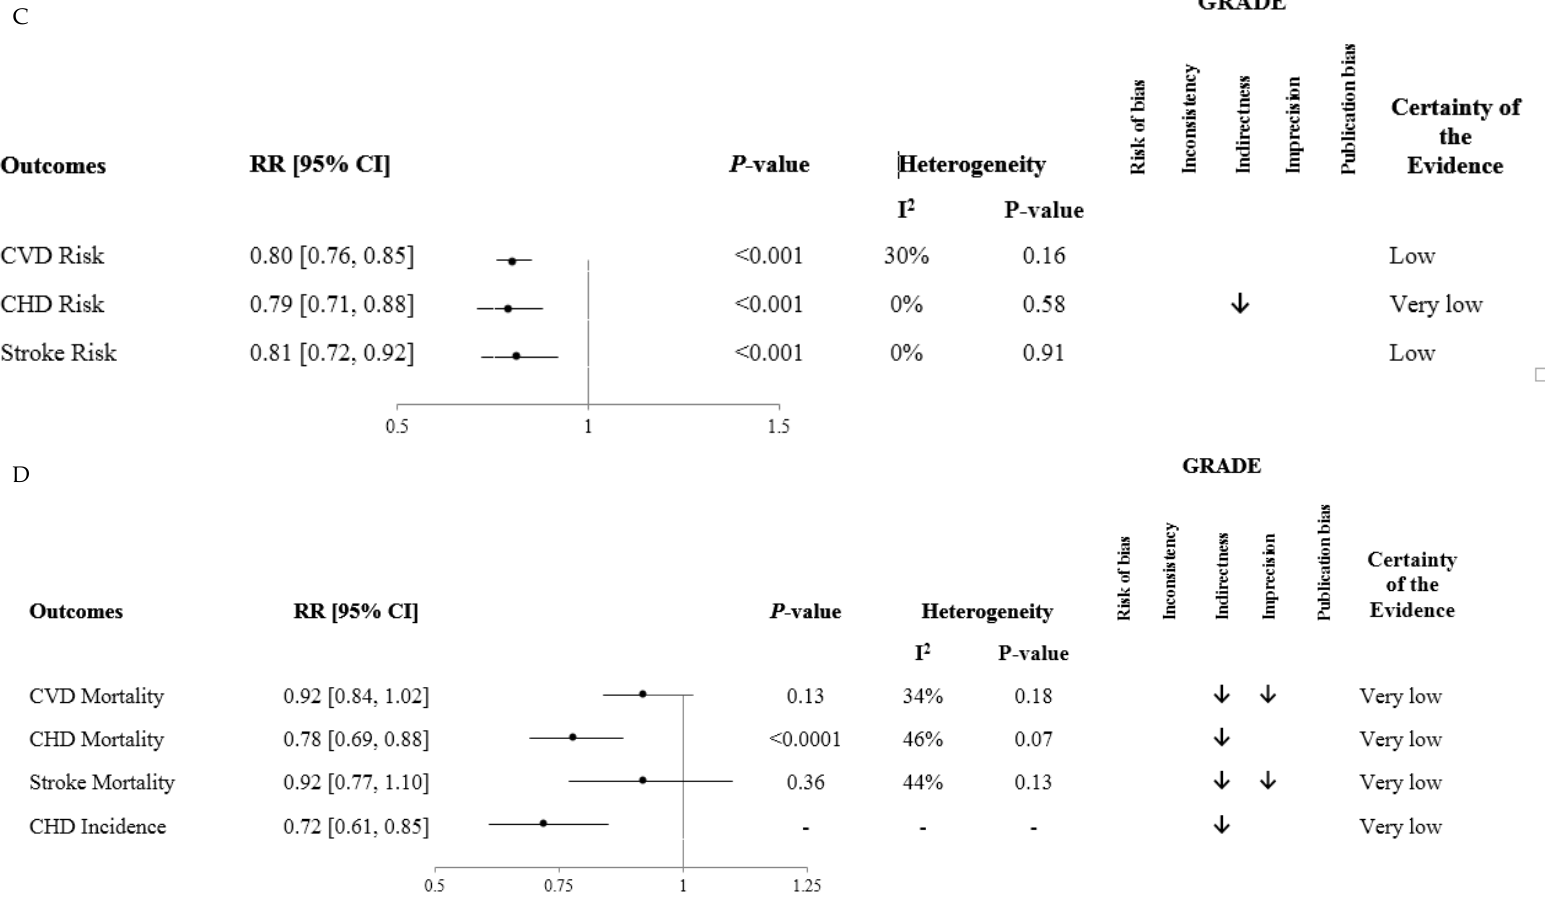
Figure 2. Summary and GRADE of the pooled effect estimates of prospective cohort studies, randomized controlled trials, and systematic reviews and meta-analyses assessing the association between dietary patterns and the incidence and mortality of major cardiovascular events. RR: Risk ratio. CI: confidence